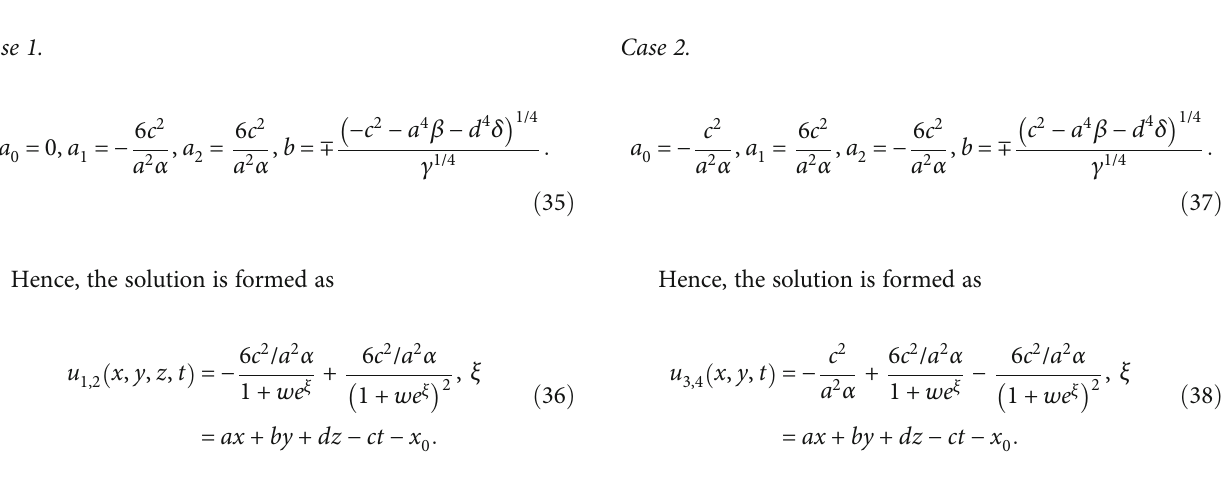
Figure 4: Graph of the absolute value of Eq. (42) for the ( 2 + 1 )-dimensional Benjamin-Ono equation at a = 2, α = 2, β = − 3, c = 2, γ = 2, r = 1, w = 0 : 3, t = 20 and for 2 plot spaces y = − 10, 0, 1